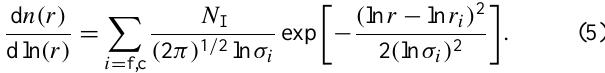
Fig. 2. Influence of random uncertainties in the input data on the discrepancy ρ(m R ) . The simulation was performed for the same Fig.2. Influence of random errors in the input data on discrepancy  (m parameters as in Fig. 1 and the maximum value of m I was 0.01. The performed for the same parameters as in Fig.1 and the maximum value of m results are presented for ten realizations with random errors in the results are presented for ten realizations with random errors in the range of 0-10%. The solid red range of 0–10%. The solid red line represents ρ(m R ) in the absence of input errors; the arrow shows the model value of the real part of line represents  (m ) in the absence of input errors; the arrow shows the model value of the real R the refractive index m R = 1 . part of the refractive index m =1.45. R